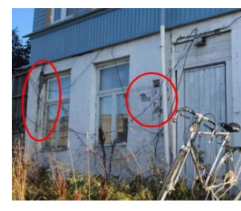
Figure 11. Humidity damage (NTNU).